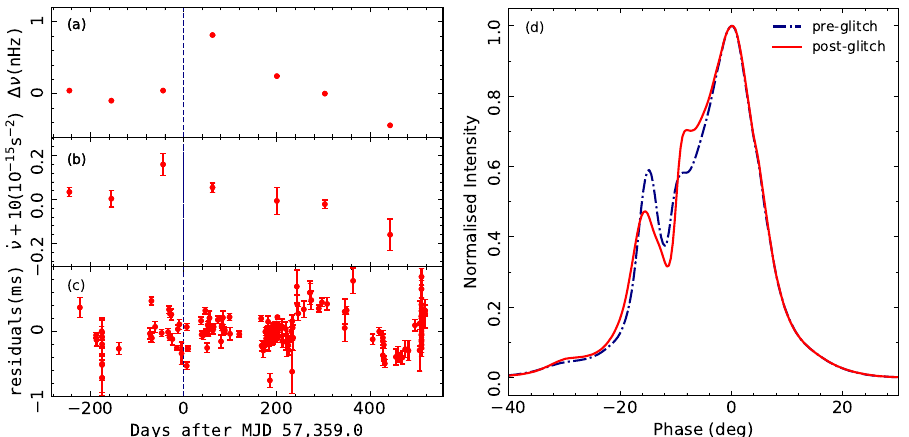
Figure 8. Emission-rotation correlation in PSR J0738–4042 reported by Zhou et al. [53]: ( a ) variations of the frequency resuduals ν ; ( b ) the variation of ˙ ν ; ( c ) the post-fit residuals after adding the glitch terms to the timing model. ( d ) the integrated normalized pulse profiles at pre- (blue line) and post-glitch (red line) modes. The vertical line indicates the glitch epoch at MJD ∼